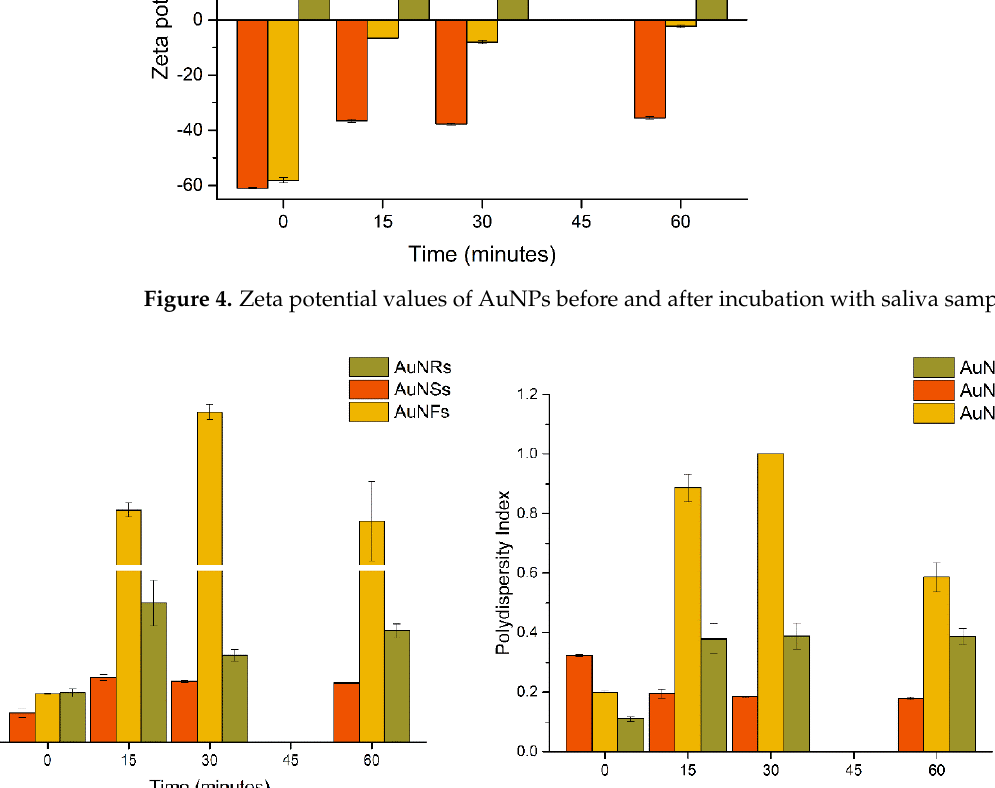
Figure 4. Zeta potential values of AuNPs before and after incubation with saliva samples.